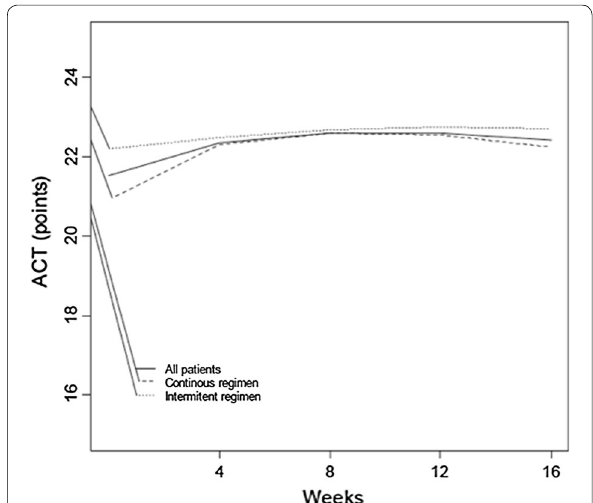
Fig. 3 Curve fitting for ACT/cACT scores from randomization to the end of the follow up of all (continuous line), intermittent (dotted line) and continuous (dashed line)